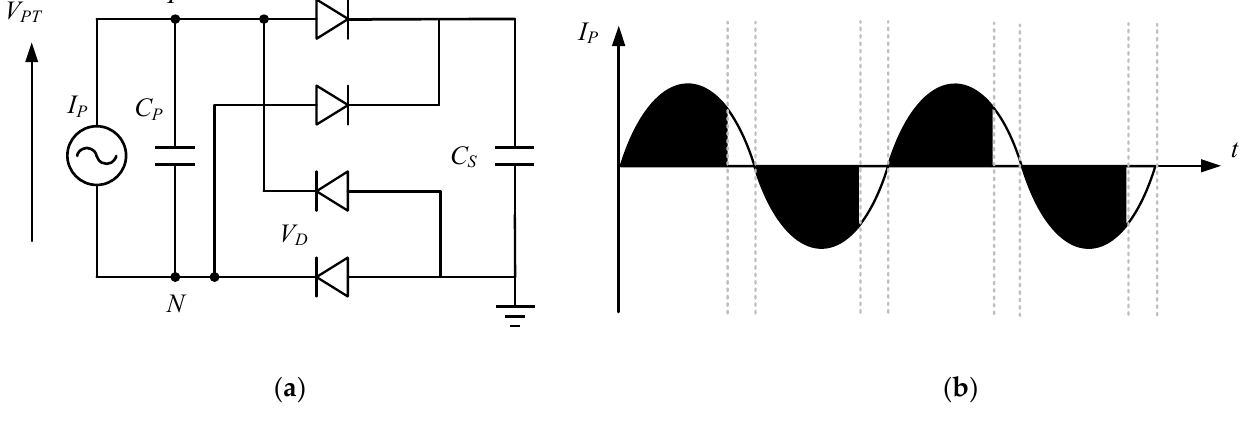
Figure 7. FBR ( a ) structure, ( b ) waveforms.